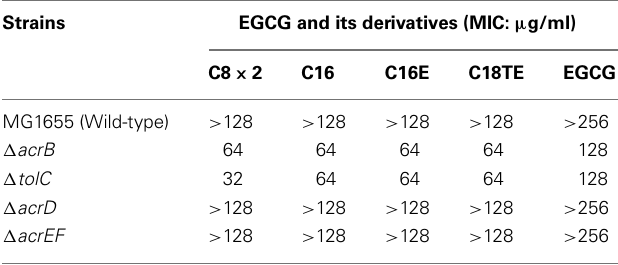
Table 7 |Activities of EGCG derivatives against efflux pump gene deletion mutants of E. coli .